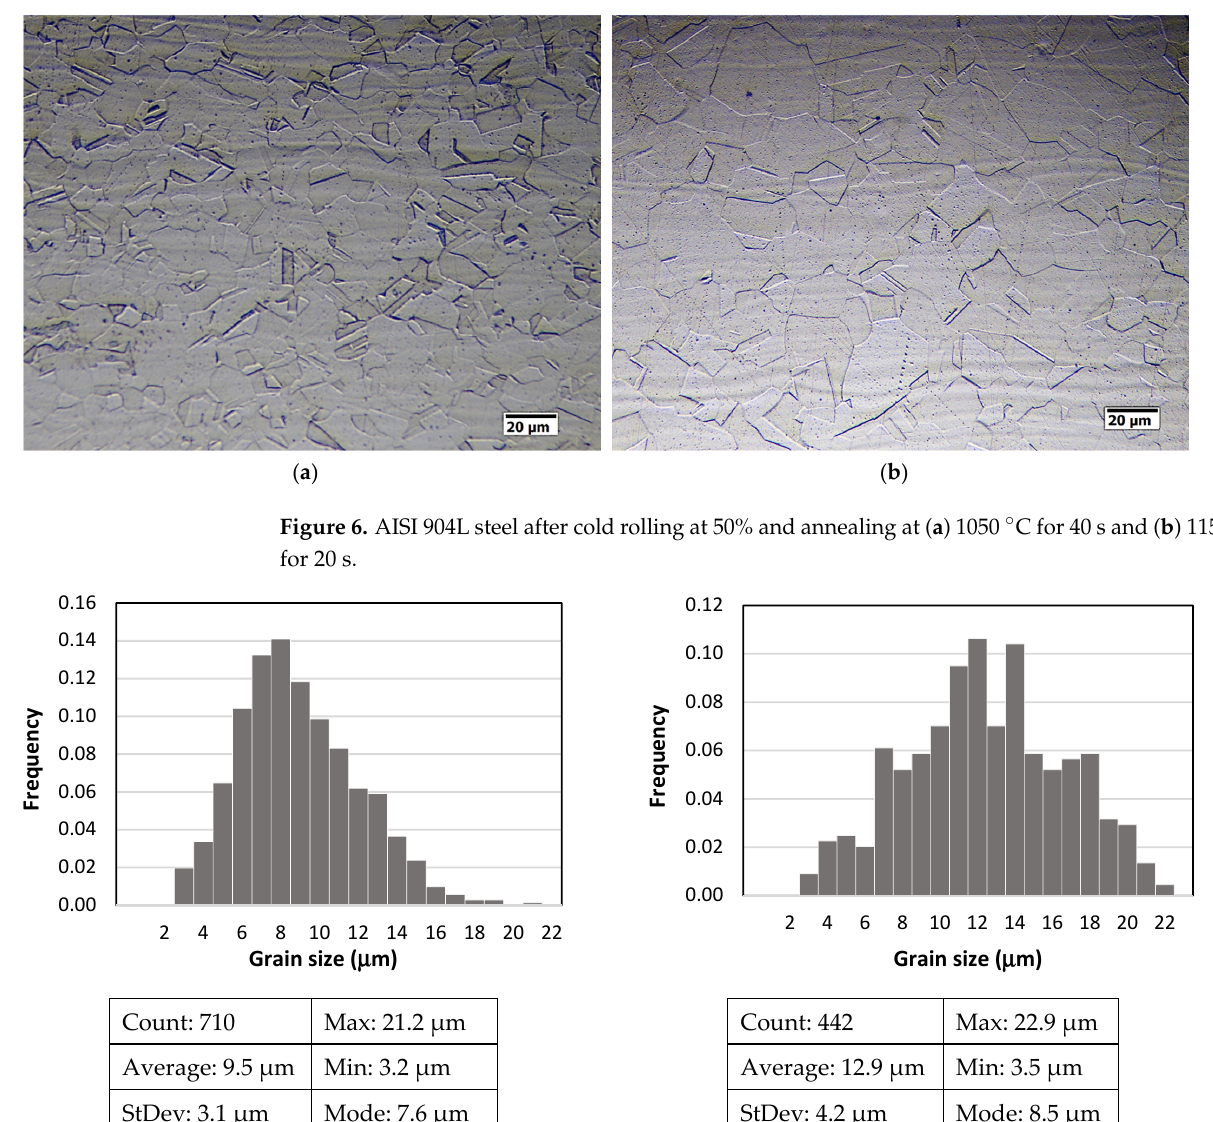
Figure 5. AISI 904L steel after cold rolling at 50% and annealing at 950 °C for 180 s (red arrows indicate the partially recrystallized areas).